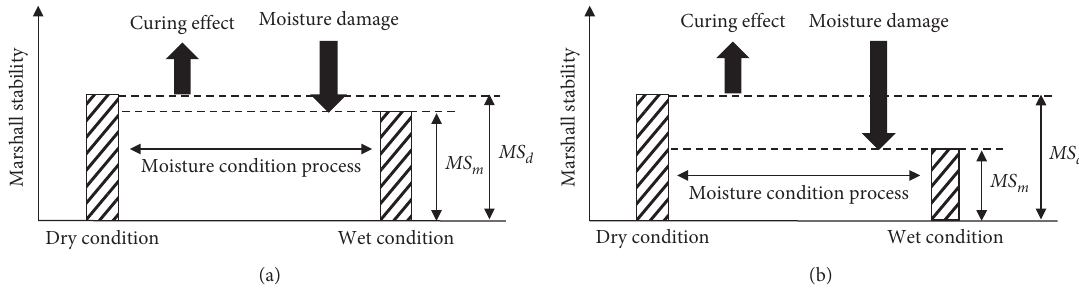
Figure 6: RMS for (a) short- and (b) long-term performance.